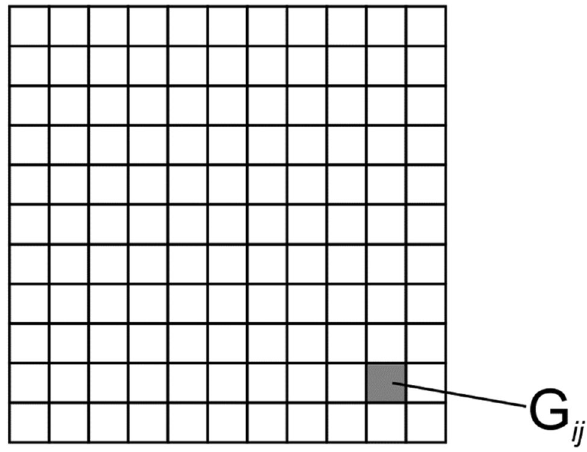
Figure 6. Schematic diagram of the partitioning of an optical element into elementary regions.